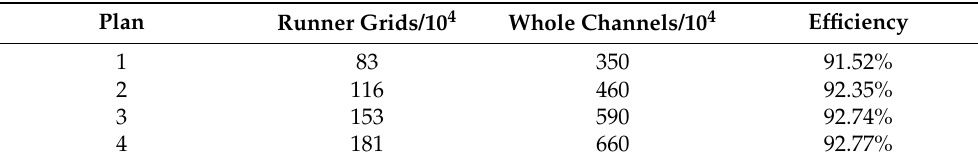
Table 3. Grid irrelevance verification.